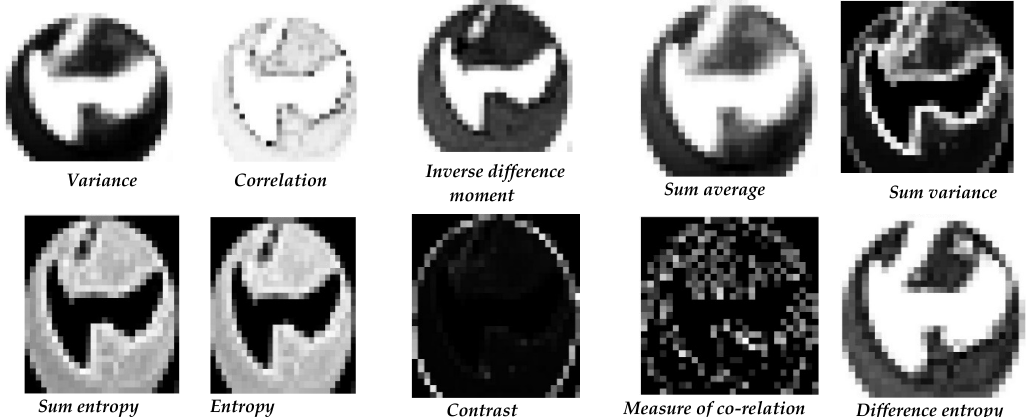
Figure 19. Gray-level co-occurrence matrix (GLCM) texture features of all the ten parameters using 64 x 64 quadtree size.